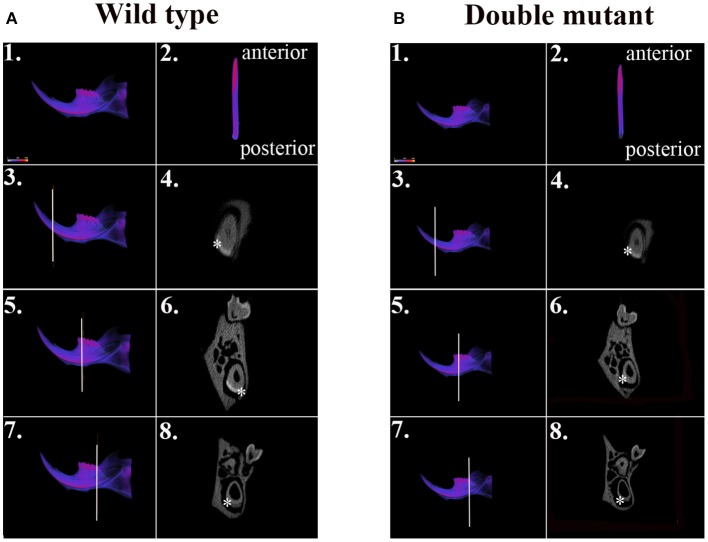
μCT analysis of wild-type and double-mutant mandibular incisors. (A1) Wild-type semi-mandible. (A2) Wild-type incisor viewed from the labial surface. (B1) Double-mutant semi-mandible. (B2) Double-mutant incisor viewed from the labial surface. We selected three regions to analyze the enamel density of incisors, which are indicated by the three reference planes along the long axis of mandibular incisors. The first reference plane was placed at the region where bony support begins (A3,B3). The second and the third reference planes sectioned though the first (A5,B5) and the third mandibular molars (A7,B7). In the wild-type sample, the three reference planes from anterior to posterior represent late maturation, maturation and secretory stages, respectively. (A4,A6,A8,B4,B6,B8) Are cross-sectional views of the regions of the three reference planes. Colors varying from blue to red in (A1–A3,A5,A7,B1–B3,B5,B7) indicate an increase in density. The area of mandibular incisor enamel is labeled by * in (A4,A6,A8,B4,B6,B8).